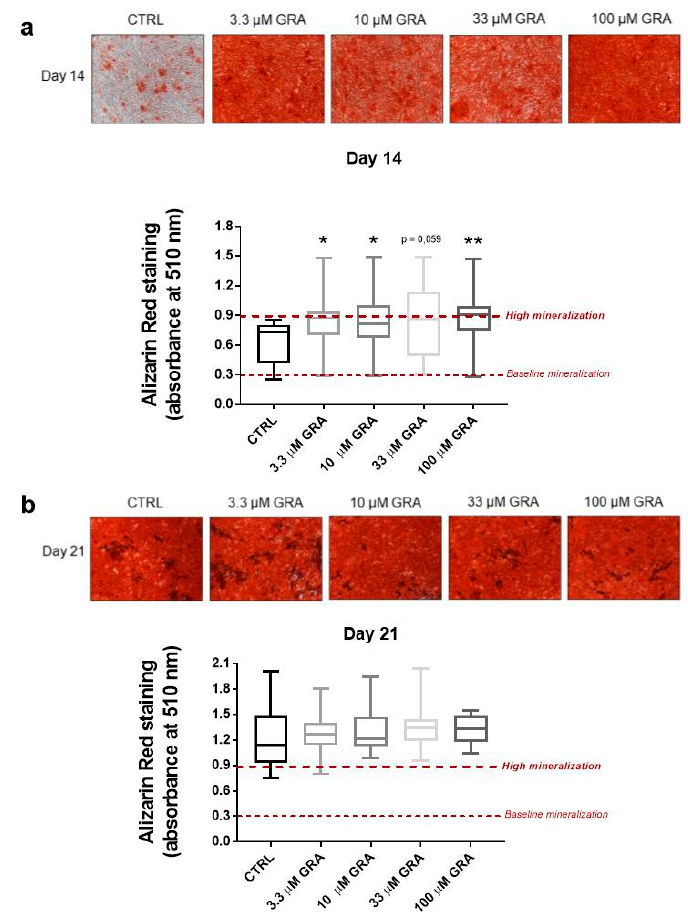
Figure 4. Mineral apposition in hMSCs after stimulation with GRA; Representative pictures (magnification 100 × ) and box plot showing the quantification of mineral apposition at day 14 ( a ) and day 21 ( b ) in hMSCs stimulated with 3.3–100 μ M concentration of GRA ( N = 6 independent experiments, showed as median, min—max values). One-way ANOVA and Dunnett’s multiple comparison tests were performed for the statistical analysis (* p < 0.05 and ** p < 0.01 vs. control day 14).